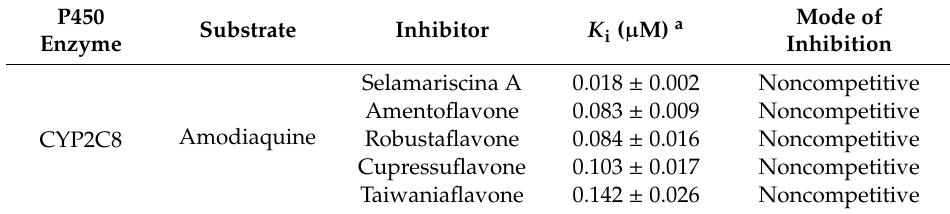
Table 4. K i values for inhibition of CYP2C8-catalyzed amodiaquine N -deethylation in human liver microsomes by five